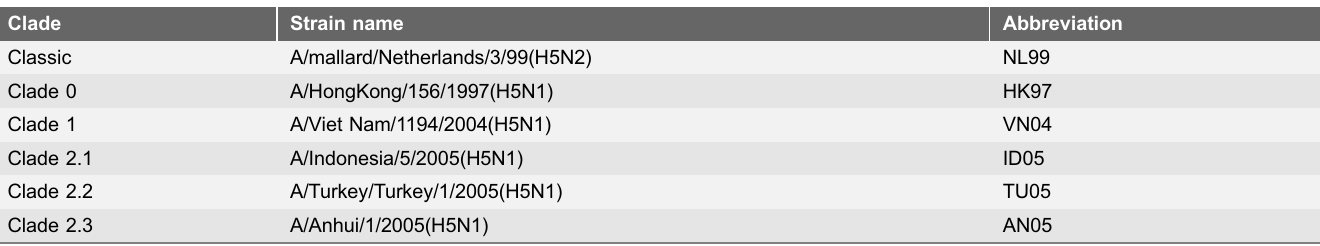
Table 1. Recombinant virus strains.